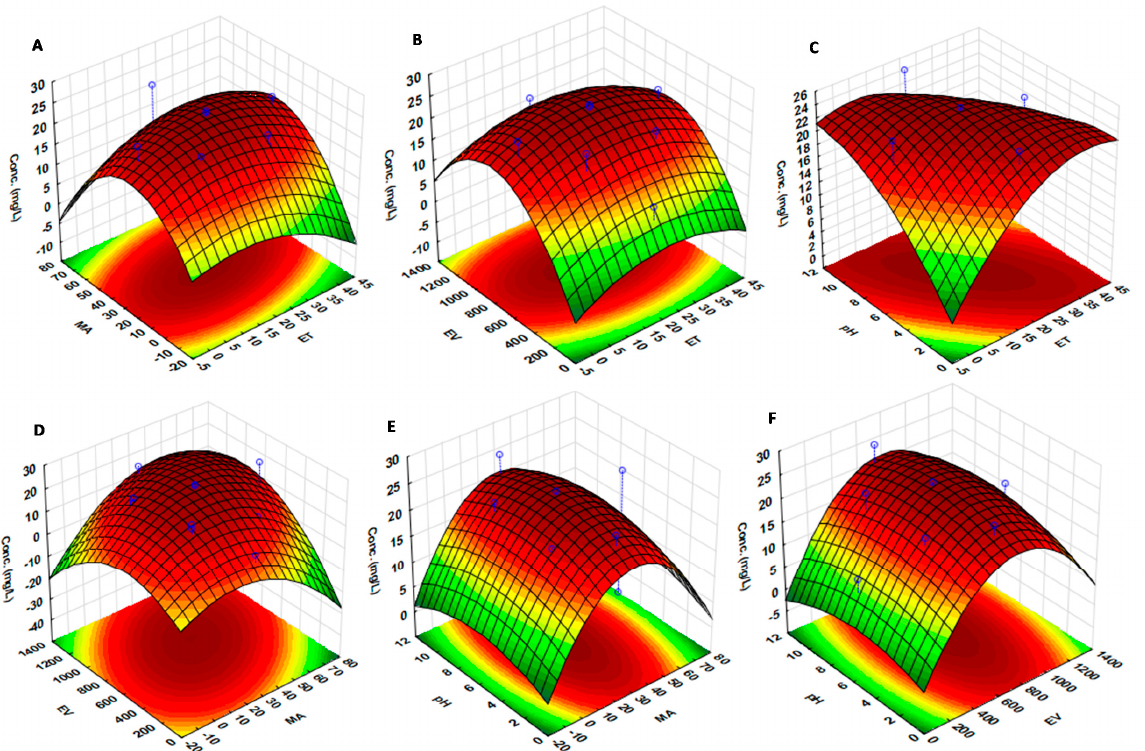
Figure 6. Response surface methodology plots showing the interaction between the independent factors ( A ) MA and ET, ( B ) EV and ET, ( C ) pH and MA, ( D ) pH and ET, ( E ) EV and MA and ( F ) pH and